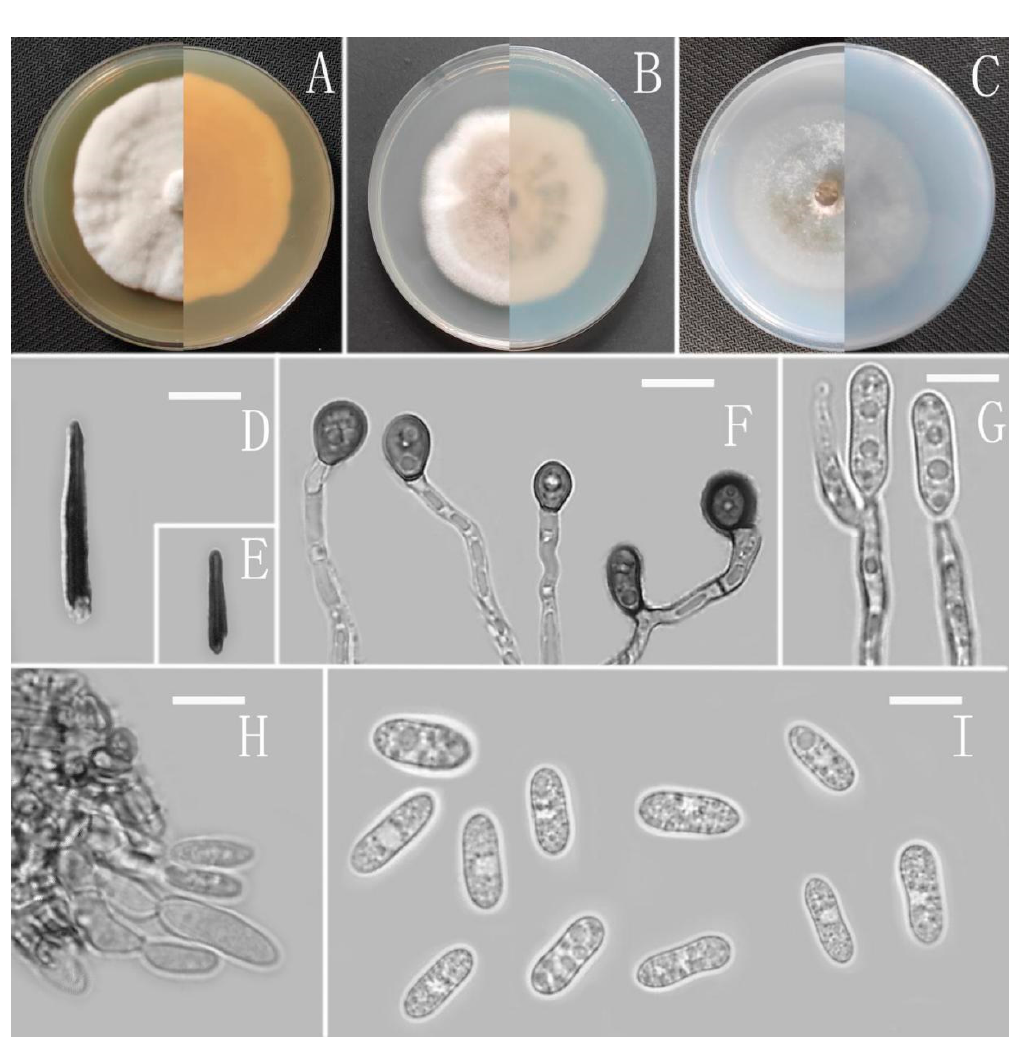
Figure 13. Colletotrichum speciosum (YMF1.07301). ( A – C ) Colonies on media above and below after 7 days at 25 °C (( A) MEA; ( B) PDA; ( C) SNA). ( D , E ) Setae. ( F ) Appressoria. ( G ) Conidiophores. ( H ) Conidiophores and Conidia. ( I ) Conidia. Scale bars: ( D – I ) = 10 μ